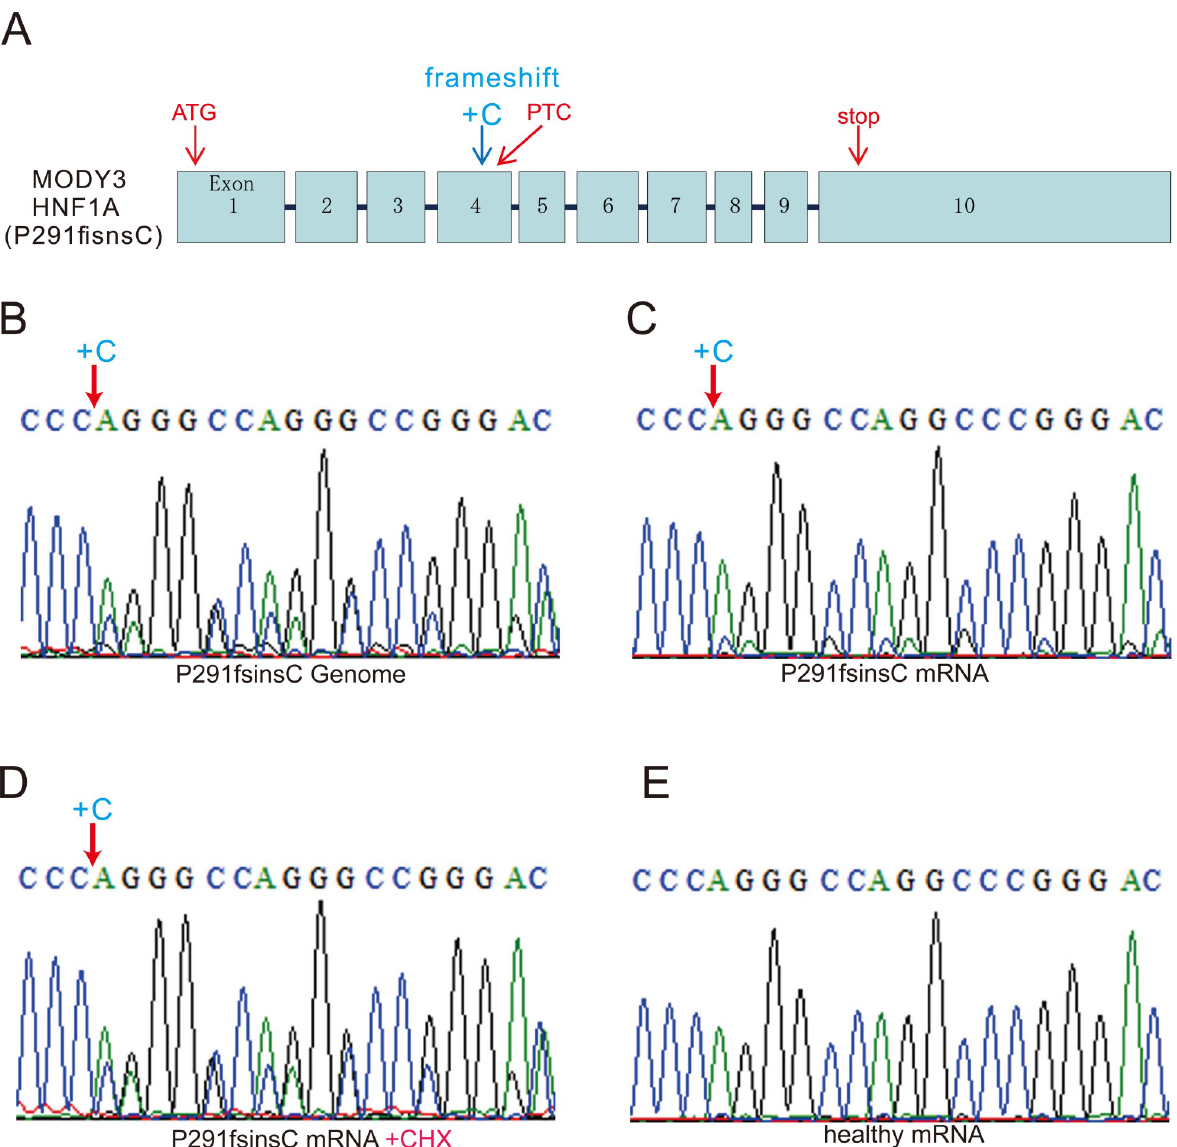
Fig 3. Sequences of wild and P291fsisnC mutant mRNA. (A) Genomic structure of HNF1A in the MODY3 patient. The original start and stop codons exist in exon1 and 10, respectively. In the P291fsincC mutation, a frameshift due to the insertion of cytosine brought a new PTC within s exon 4. (B-E) Sequence data for the HNF1A gene and transcripts of MODY3-iPSCs and healthy control. (B):Genomic sequence data for the MODY3-iPSCs near the mutation site. (C):Sequence data cloned from transcripts derived from MODY3-iPSCs. (D):Sequence data cloned from transcript derived from cycloheximide (CHX)-treated MODY3-iPSCs. (E) Sequence data cloned from a transcript derived from healthy cells.